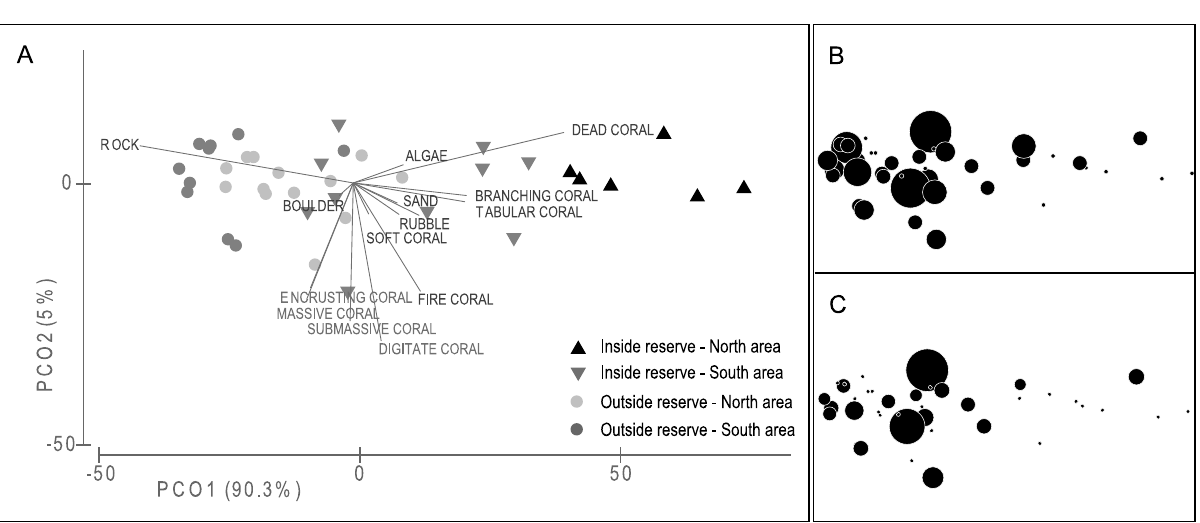
Fig 2. Habitat typology in the study area. Results of PrincipalCoordinates Analysis (PCO) of the reef stations basedupon benthichabitat variables: (a) station plot by zone (North, South) vs. protection status (inside, outsidethe reserve). Same plots with black circles proportional to: (b) the density and (c) the legal-sized biomass of trochus topshell( T . niloticus ).